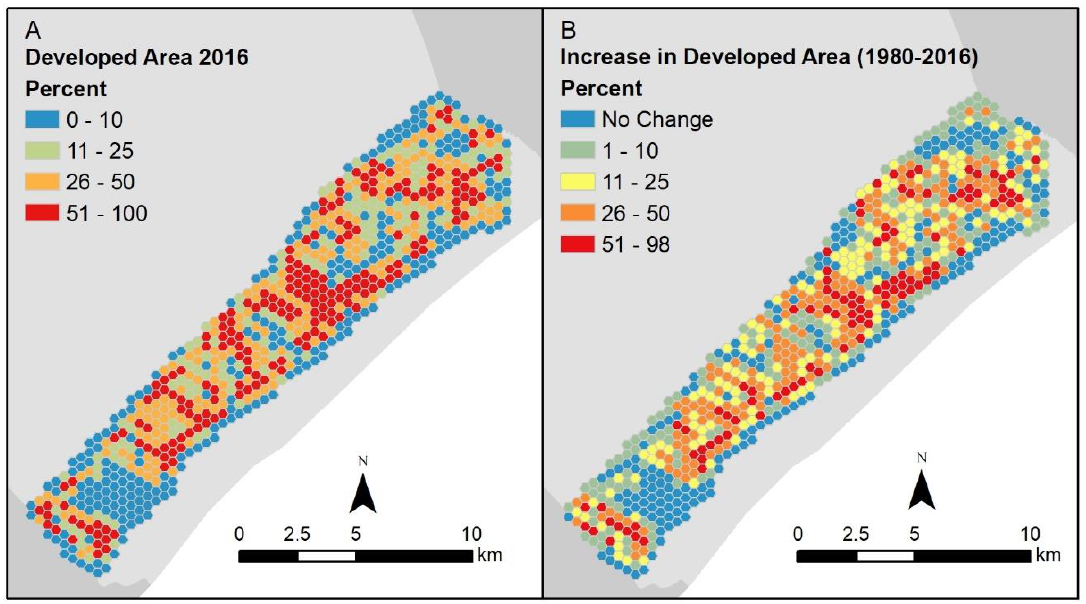
Figure 12. Amount of developed land cover in 2016 ( A ) and percent change from 1980 to 2016 ( B ). (Data source: NAIP).